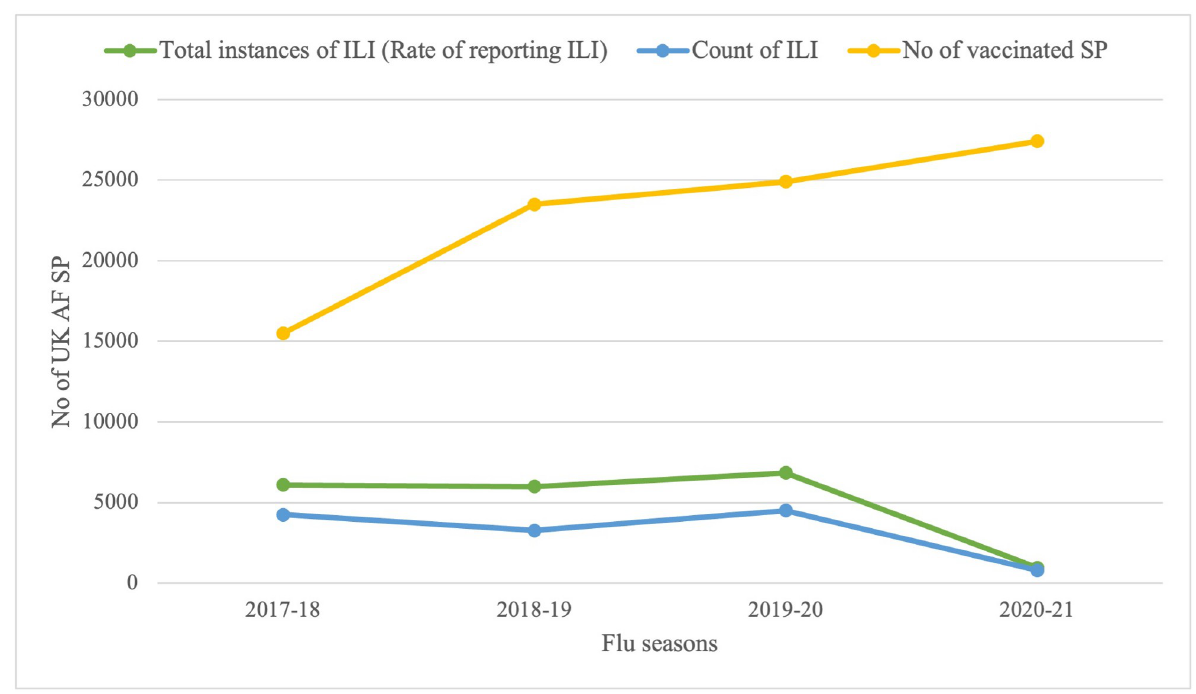
Fig 3. Relationship between the rate of reporting ILI, the count of ILI and vaccination rate in the UK AF before and during the COVID-19 pandemic.